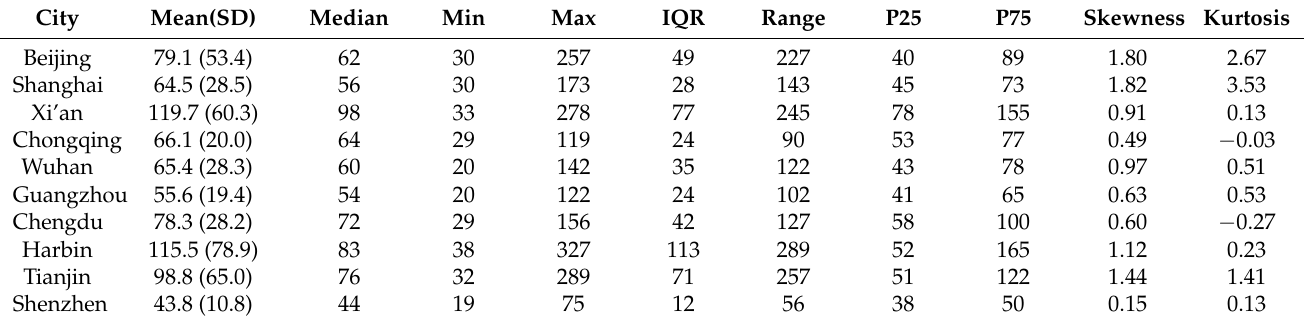
PM -10 concentration, respectively. Beijing and Harbin recorded the least (4.8 µ g m − 3 ) and highest (28.6 µ g m − 3 ) average SO 2 concentration, respectively. Shenzhen had the least average CO concentration of 0.6 mg m − 3 , while Xi’an, Wuhan, and Tianjin had the highest average CO concentration of 1.0 mg m − 3 each. Shenzhen and Tianjin recorded the least (21.9 µ g m − 3 ) and highest (43.9 µ g m − 3 ) average NO 2 concentration, respectively. Chongqing and Shanghai recorded the least (51.8 µ g m − 3 ) and highest (84.1 µ g m − 3 ) average O 3 concentration, respectively. Table 1. Descriptive statistics for air quality index (AQI; µ g m − 3 ) in 10 mega-cities during the COVID-19 outbreak.